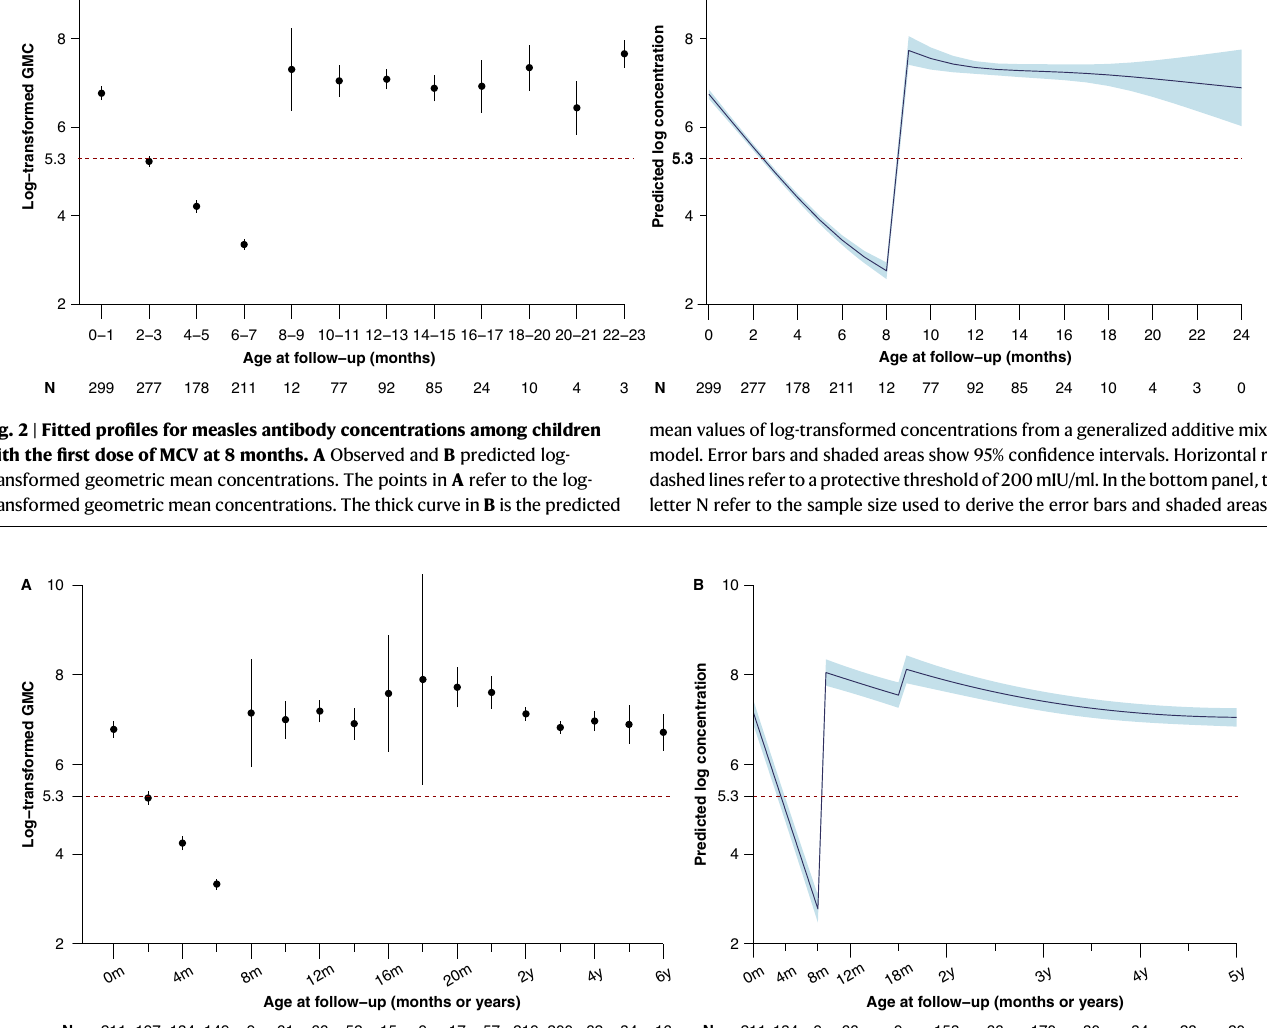
Fig. 3 | Fitted pro fi les for measles antibody concentrations among children with a two-dose routine vaccination schedule consistent with the recommen- dationofChina ’ s national immunizationprogram. A Observed and B predicted log-transformed geometric mean concentrations. The points in A refer to the log- transformed geometric mean concentrations.The thickcurve in B is the predicted